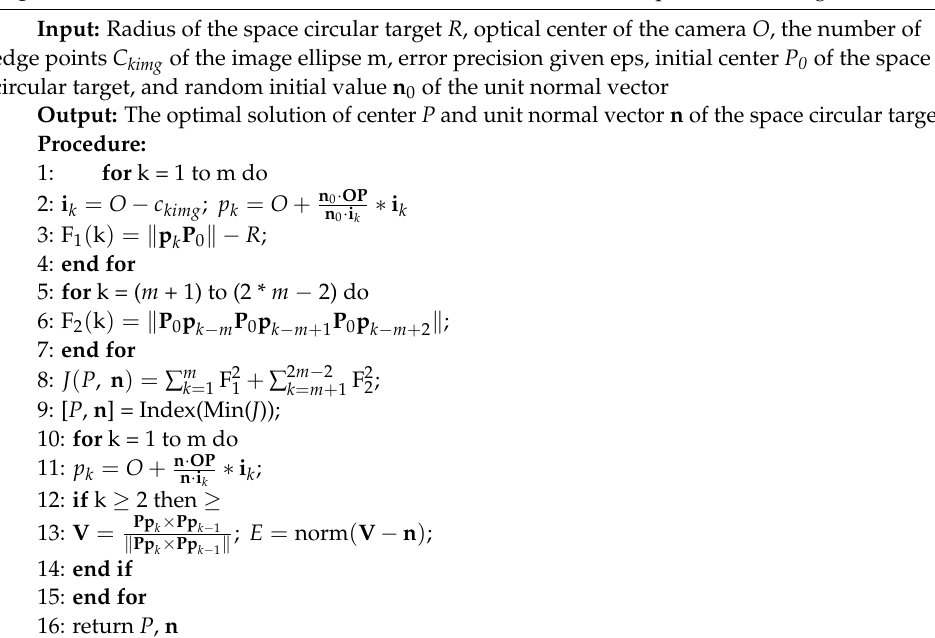
Algorithm 1: Detection of the center P and normal vector n of the space circular target Input: Radius of the space circular target R , optical center of the camera O , the number of edge points C kimg of the image ellipse m, error precision given eps, initial center P 0 of the space circular target, and random initial value n 0 of the unit normal